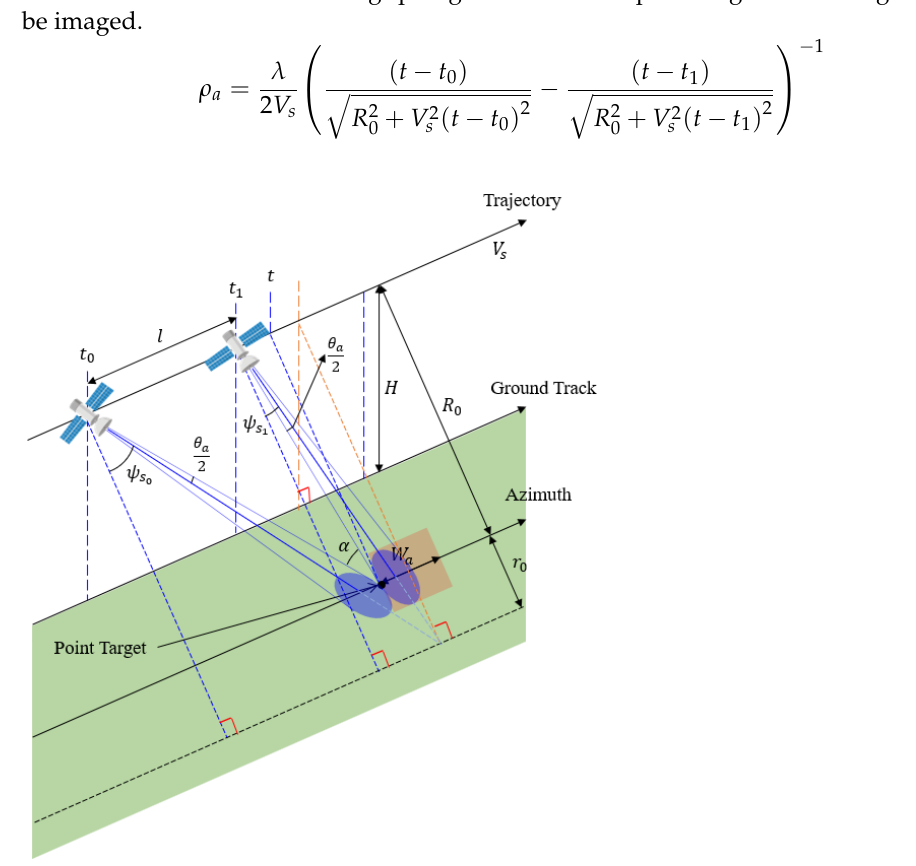
Figure 6. Image-taking geometry of a point target within target scene for broadside sliding spotlight SAR.